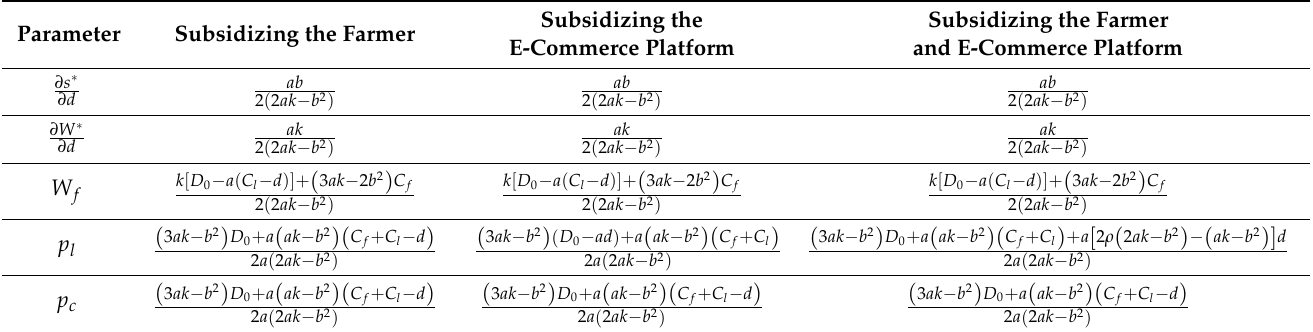
Table 2. Analysis of the influence of government subsidy on decision variables of the supply chain. Subsidizing the Subsidizing the Farmer Parameter Subsidizing the Farmer E-Commerce Platform and E-Commerce